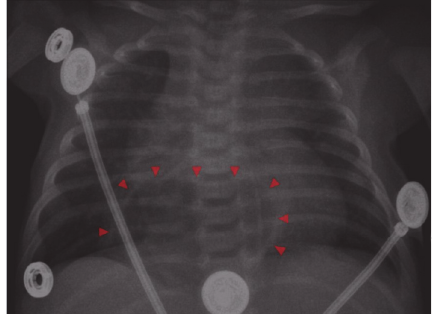
Figure 3: AP chest X-ray showing a radiolucency over the cardiac silhouette just above the diaphragm (arrowhead).